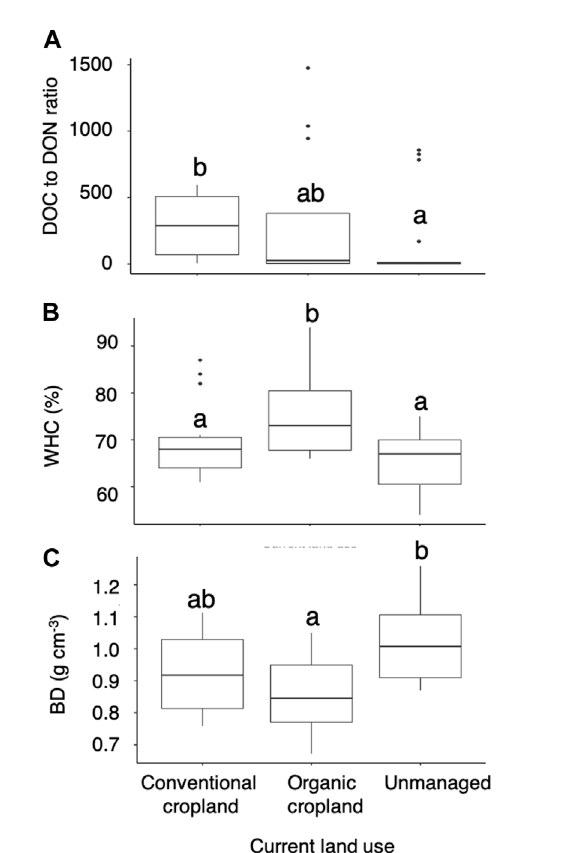
FIGURE 7 Boxplots for the proposed key indicators of health (DOC to DON ratio, (A) ; WHC, (B) ; BD, (C) ) for a subset of soils across land use classes forconventionalcropland,organiccropland,andunmanagedpreviously intensive agriculture averaged across high (HAC) and low activity clay (LAC) soils. Means sharing a letter are not signi fi cantly different (Tukey-adjusted comparison of least square means at p-value < .05.) n =